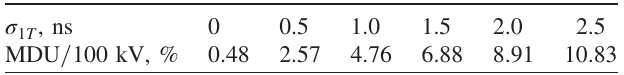
TABLE IV. Flatness of the top of the output pulse of the LTD cavity depending on the switch jitter.